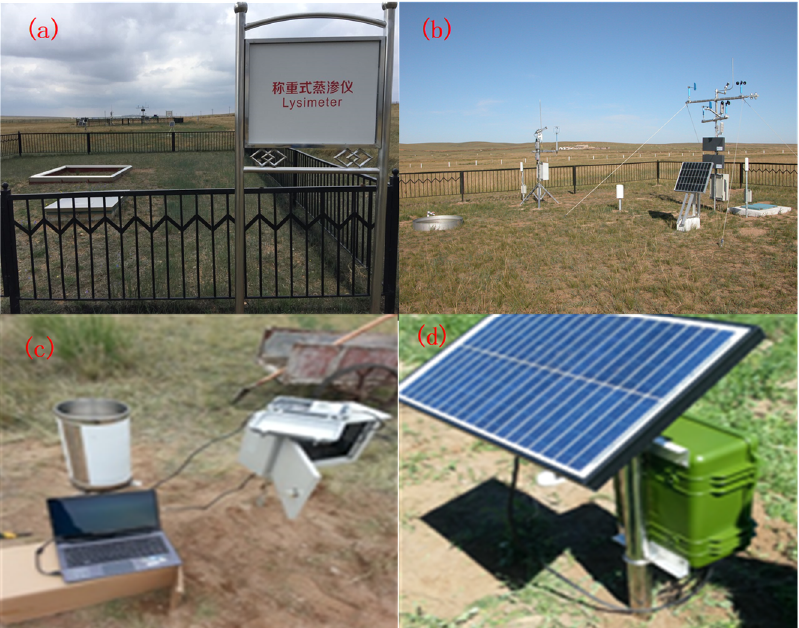
Figure 2. Field multi-water joint observation system: ( a ) large-scale auto-weighing lysimeter, ( b ) Environmental Information System (ENVIS) ecological meteorological gradient observation system, ( c ) bucket type rain gauge, and ( d ) self-recording layered soil moisture meter.